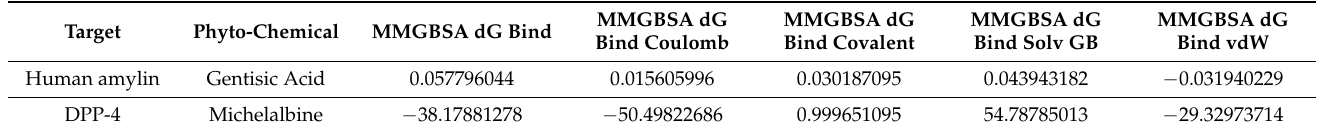
Table 2. Binding energies (MMGBSA) of the target and the best